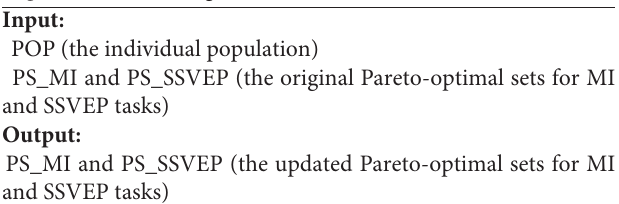
Algorithm 1 First stage of EMMOA. TABLE 1 | Parameter settings of algorithms.